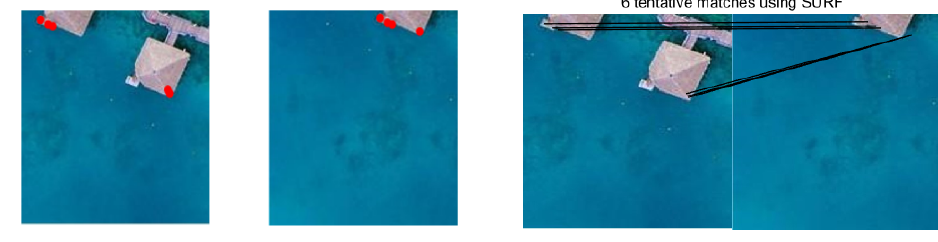
Figure 1. In the traditional sample diagram of feature-point detection and matching, feature points can hardly be detected in a region with weak texture, resulting in incorrect matching.